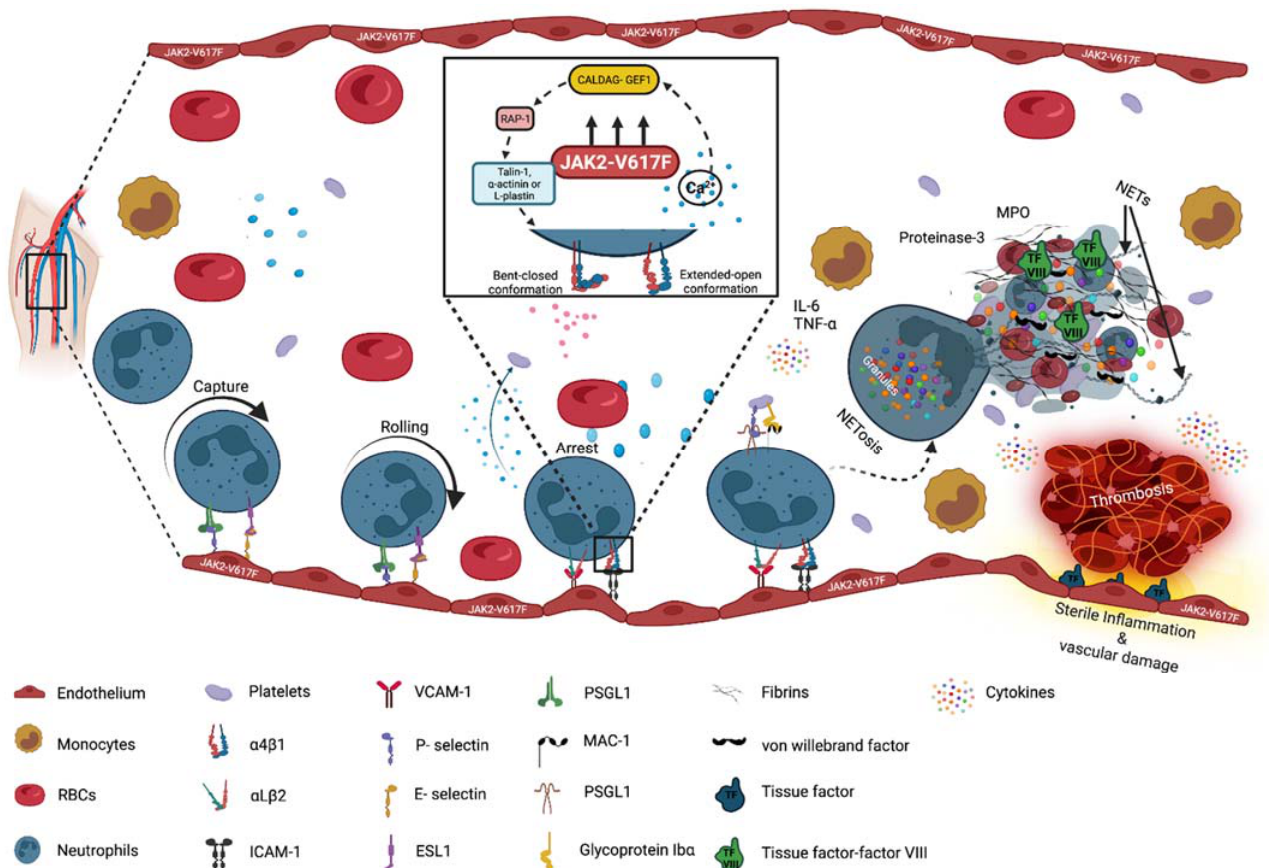
Figure 1. Neutrophil-associated thromboinflammation in MPNs. The constitutive activity of mutated JAK2-V617F kinase increases intracellular Ca 2+ and supports Ca 2+ influx followed by CalDAG-GEF1 (calcium- and diacylglycerol-regulated GEFI) activation. This results in the activation of small guanosine triphosphate hydrolase enzymes (GTPases), such as RAS-related protein 1 (RAP1), which further stimulate integrin-binding proteins to facilitate integrin conformational changes in neutrophils. The activation of integrins assists neutrophils in inducing thromboinflammation, which is a multistep process where activated neutrophils, inflammatory cytokines, the aggregation of platelets, and induction of plasmatic coagulation synergize. Initially, under flow conditions, neutrophils interact with endothelium-expressed P- and E-selectin with their respective PSGL-1 and ESL1-ligands, which allow neutrophils to slowly roll along the blood vessel. While rolling, neutrophils are arrested upon the binding of β 1 and β 2 integrins (VLA-4, LFA-1) to the endothelium-expressed VCAM-1 and ICAM-1. Inflammatory cytokines, such as IL-6 and IL-17, foster this process by up-regulating VCAM-1 and ICAM-1 expression. The release of chemokines leads to chromatin decondensation in neutrophils, which then expel granular proteins, including neutrophil elastase (NE), myeloperoxidase (MPO), and DNA material into the extracellular space to form NETs. The formation of NETs further induces thrombosis by activating plasmatic coagulation and by inducing the aggregation of platelets and erythrocytes. (This figure was created with BioRender.com, assessed on 15 February 2022). Little is known about the contribution of platelets to the prothrombotic state associ- ated with JAK2-V617F-induced MPN. Experimentation using JAK2-V617F-positive mice